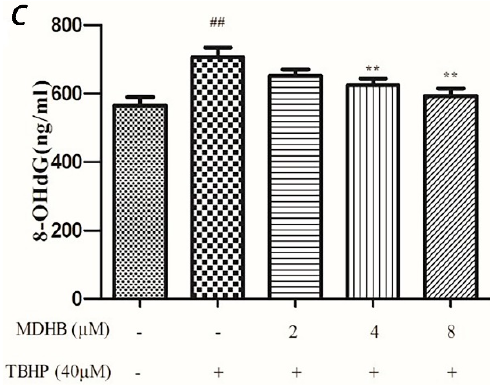
Figure 5. ( A ) Effect of MDHB on intracellular SOD activity in SH-SY5Y cells. SH-SY5Y cells were treated with MDHB (2, 4, or 8 µ M) for 4 h before exposure to 40 µ M TBHP for another 24 h. Intracellular SOD activity was estimated using WST-1 assay. Data are expressed as the mean ± S.E.M. ## p < 0.01 versus the control group. * p < 0.05 versus the TBHP group ( n = 4); ( B ) Effect of MDHB on intracellular GSH-Px activity in SH-SY5Y cells. Intracellular GSH-Px activity was estimated using a colorimetric assay. The data are expressed as the mean ± S.E.M. ## p < 0.01 versus the control group, ** p < 0.01 versus the TBHP group ( n = 3); ( C ) Effect of MDHB on 8-OHdG levels in the cultured media of SH-SY5Y cells. SH-SY5Y cells were treated with MDHB (2, 4, or 8 µ M) for 4 h before exposure to 40 µ M TBHP for another 24 h. 8-OHdG levels in the cultured media of SH-SY5Y cells were detected using ELISA. The data are expressed as the mean ± S.EM. ## p < 0.01 versus control group. ** p < 0.01 versus TBHP group ( n = 3).